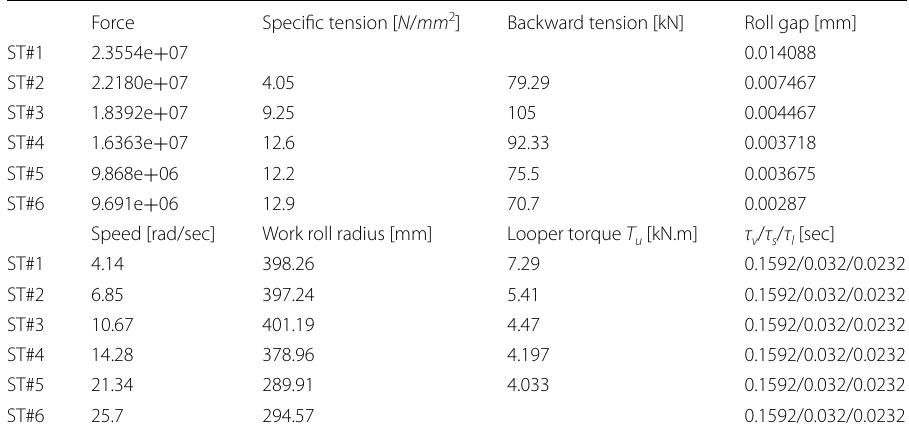
Table 4 Operation